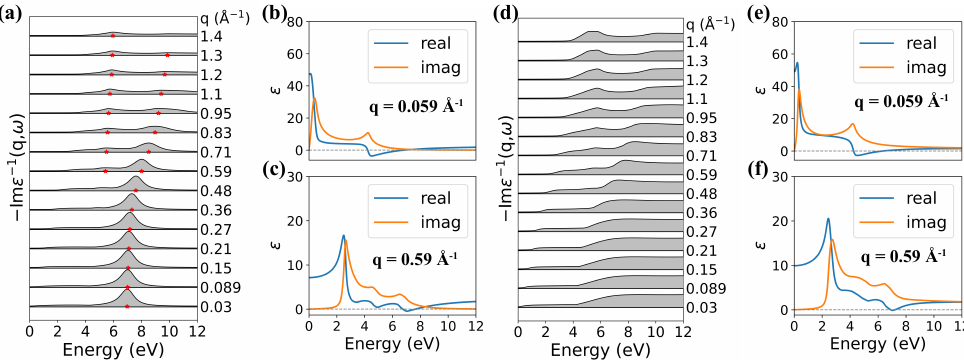
Figure 8. Calculated loss functions along the Γ M direction of AB ( a ) and ABC ( d ) graphite with LFE. The peak positions are marked by red stars. Real and imaginary part of dielectric function at ( b ) q = 0.059 Å − 1 and ( c ) q = 0.59 Å − 1 for AB graphite and ( e ) q = 0.059 Å − 1 and ( f ) q = 0.59 Å − 1 for ABC